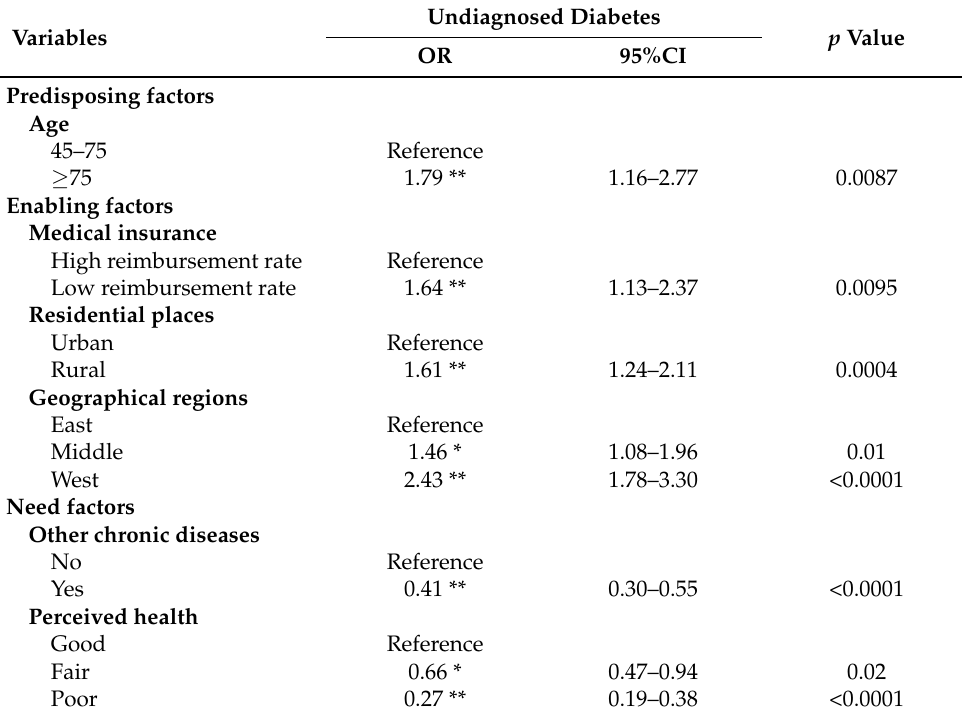
Table 2. Variables related to undiagnosed diabetes in multiple logistic regression analysis.